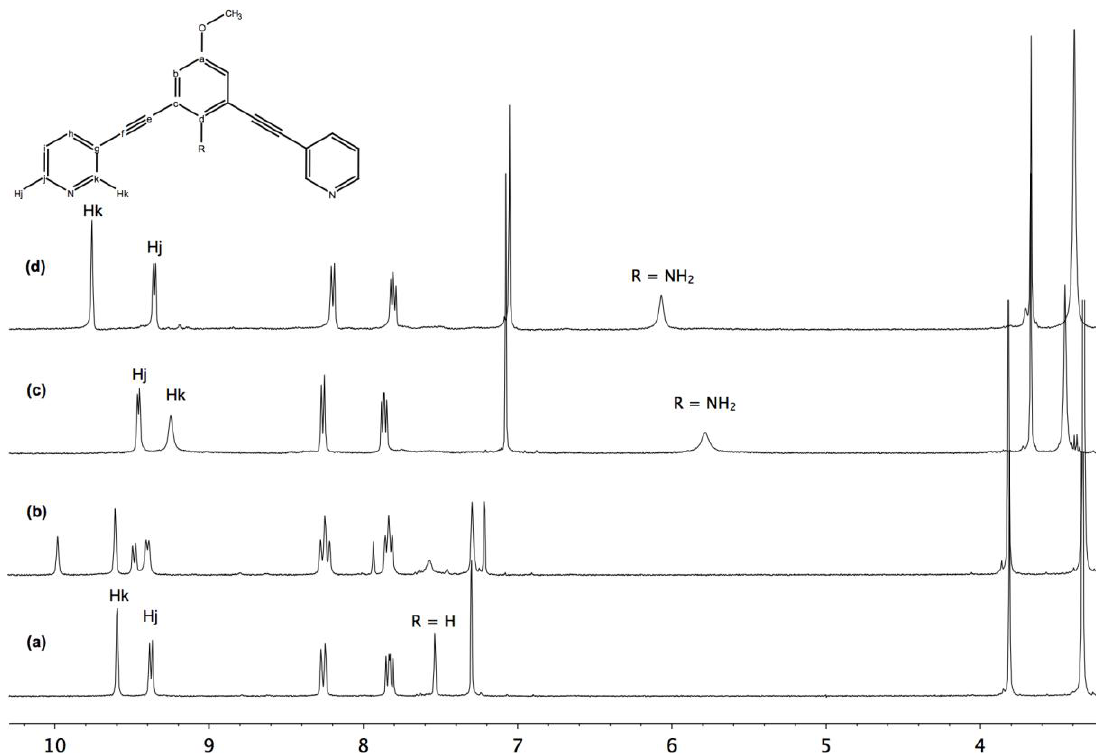
Figure 5. 1 H NMR titration of  PtCl ( 1b ) and [Pd guest; (c) cage 3 and ( d ) addition of one equivalent of